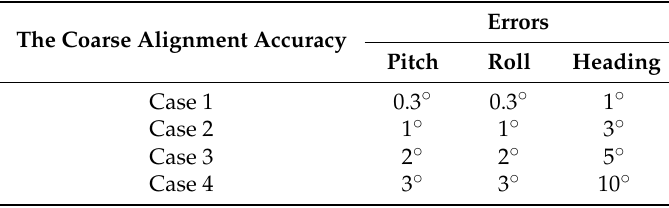
Table 1. The different initial conditions for the open-loop